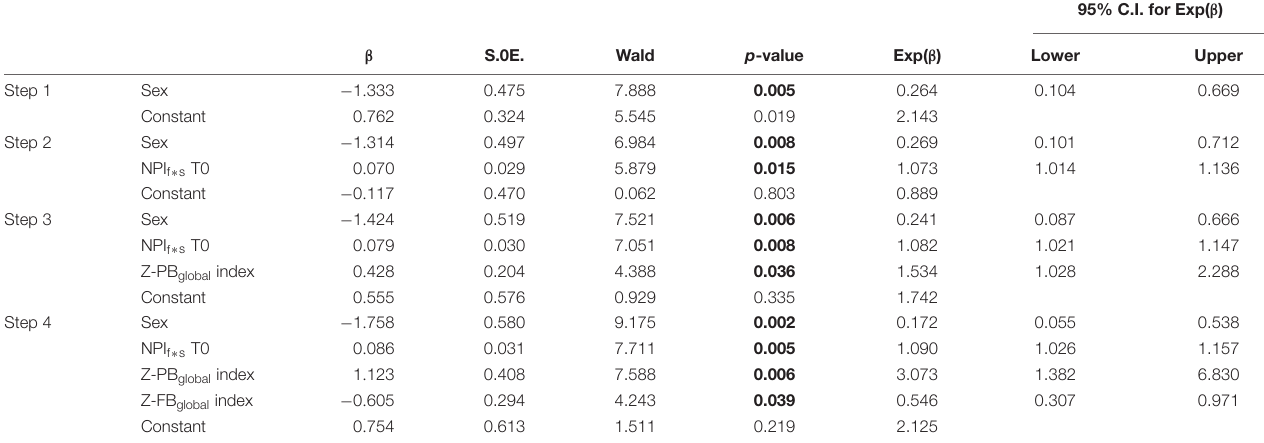
95% C.I. for Exp( β )